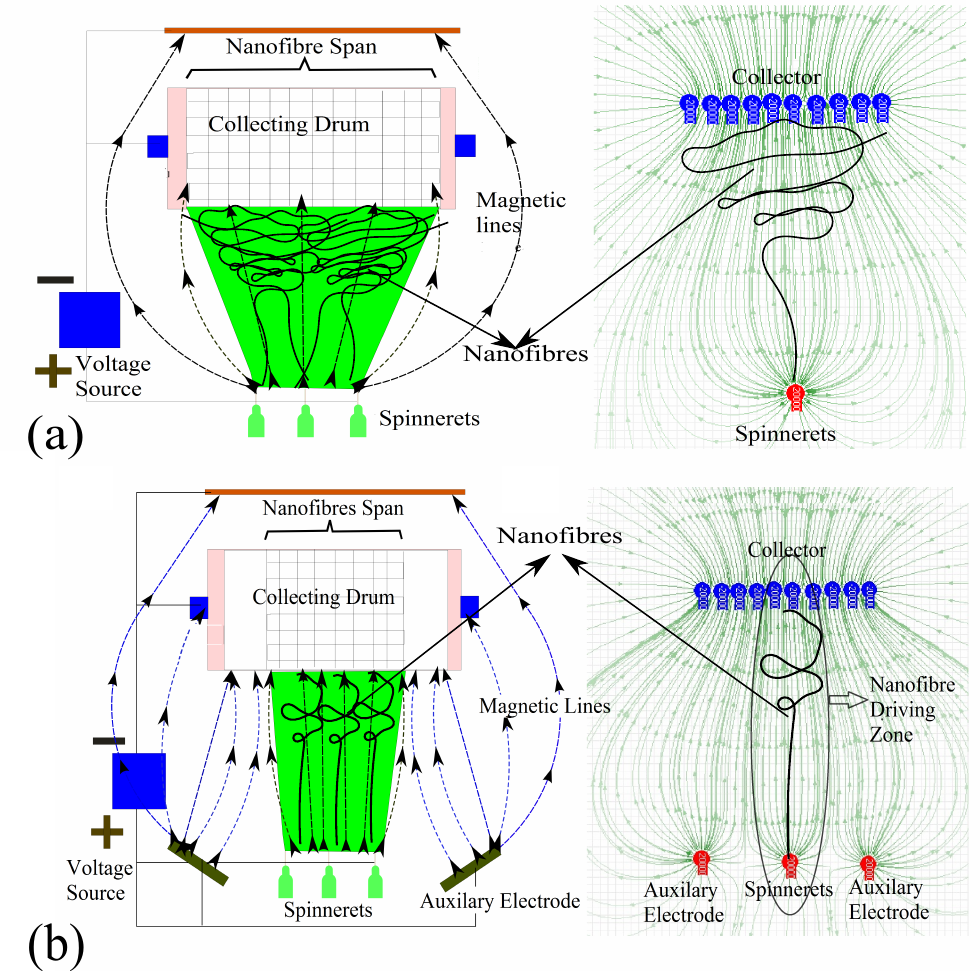
Figure 3. Electric field simulation software analysis ( a ) without AVEs; ( b ) with